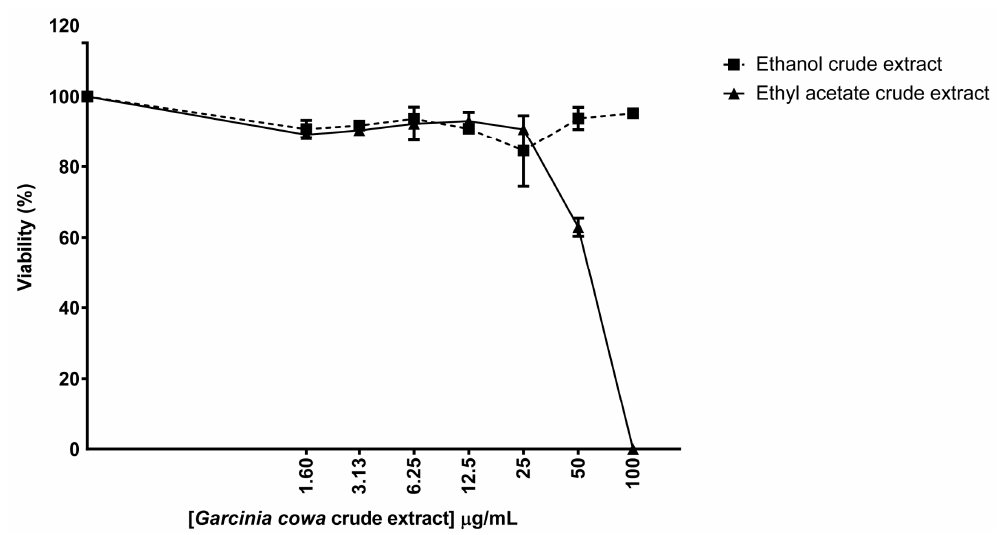
Figure 5. Ethyl acetate crude extracts from Garcinia cowa Roxb. ex Choisy affected the biosensor cell viability. The viability assay of the biosensor cells was measured following exposure with either Garcinia cowa Roxb. ex Choisy ethyl acetate or ethanol crude extract for 48 h. The experiment was repeated with biologically independent replicates. Each point is shown as the mean ± standard deviation from one experiment.